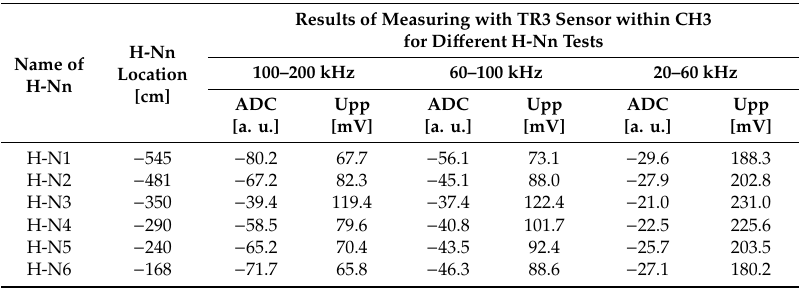
Table 3. Peak-to-peak amplitudes U pp and ADC descriptor values for the AE signals recorded with sensors TR3 in CH3 during the operation of Hsu-Nielsen sources located next to the di ff erent AE